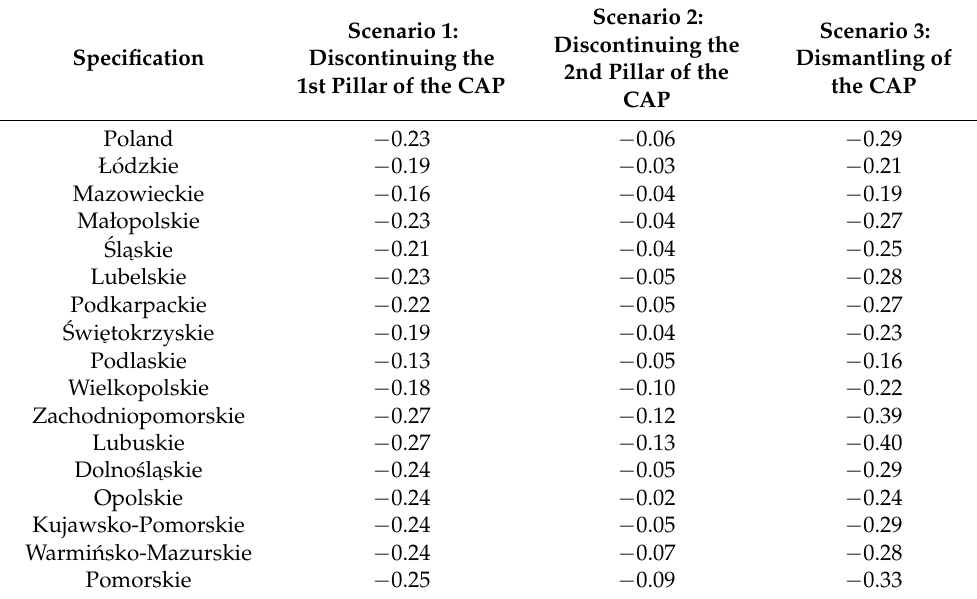
Table 1. Changes in farming income against status quo in the following cases: the 1st pillar is discontinued (scenario 1); the 2nd pillar is discontinued (scenario 2); and the Common Agricultural Policy (CAP) is totally dismantled (scenario